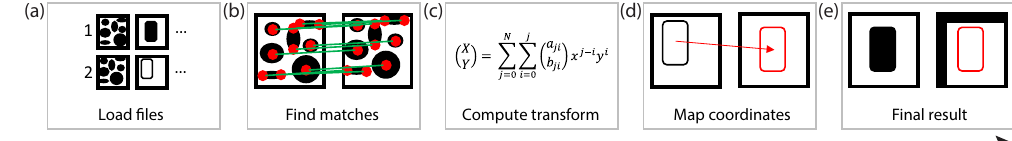
Figure 2. Illustration of the algorithm workflow. Images are loaded with a Python script ( a ), and the topographic channels are analysed through a computer vision algorithm in order to find a complete set of matching points ( b ). The matching points are then used to generate a coordinate transform ( c , d ) which is finally applied to the auxiliary data channels ( e ), enabling nanoscale correlations to be